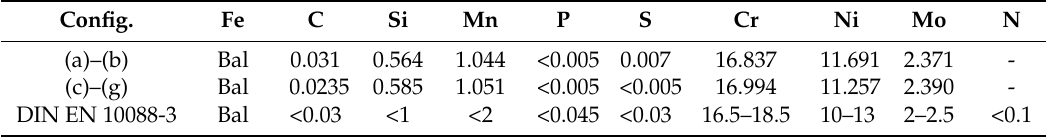
Table 3. Chemical composition of the specimens, all values in weight-percent.